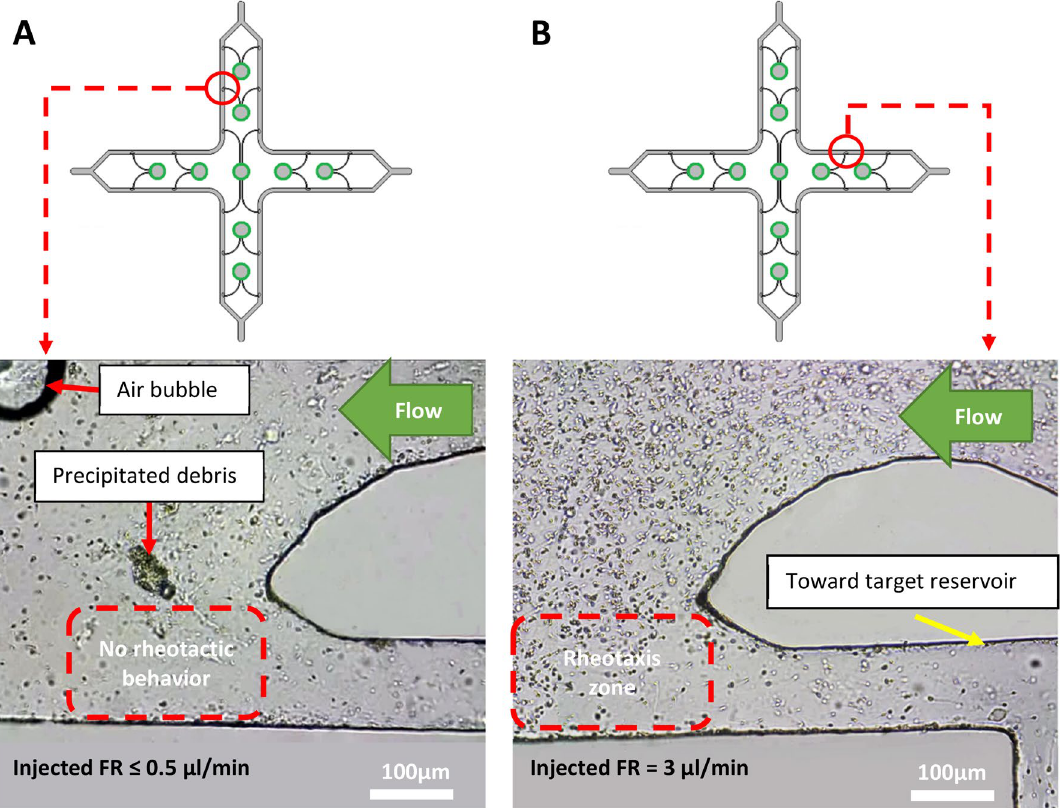
Figure 3. Rheotaxis-based separation of motile sperm. ( A ) When the injected flow rate was less than 0.5 μl/ min, none of the motile sperm displayed rheotactic behavior either inside the main channels or the rheotaxis zone. ( B ) At flow rates larger than 0.5 μl/min, such as 1.5 and 3 μl/min, the motile sperm swam against the flow direction inside the rheotaxis zone and entered the narrow curved